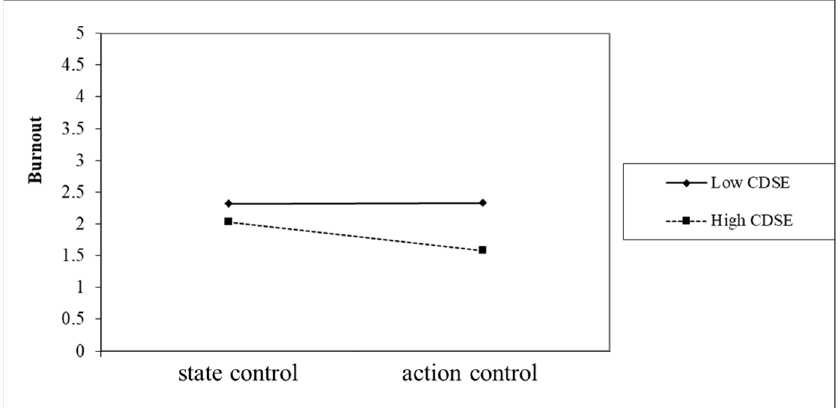
Figure 7. The moderation effect of the action control of preservice teachers with teacher identity on CDSE and burnout.